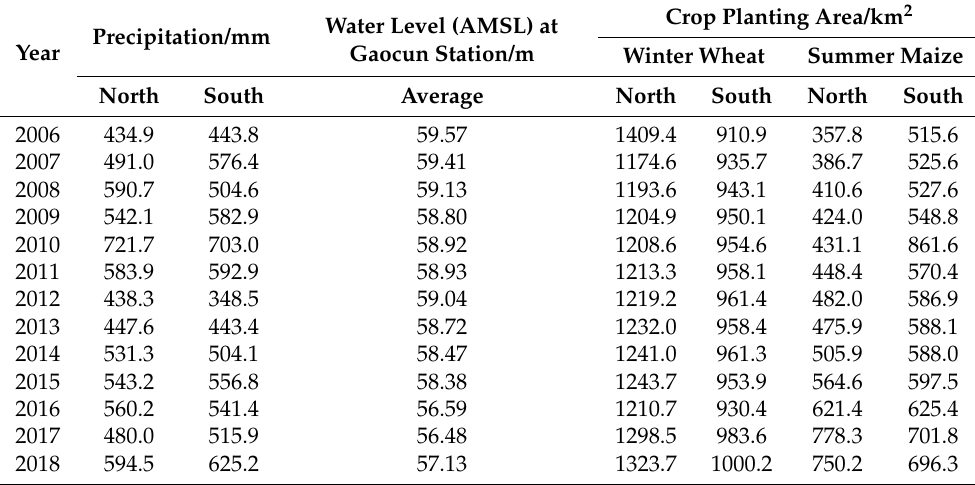
Figure 2. Distribution of observation wells of shallow groundwater in Puyang area. Table 1. Inter-annual variation of precipitation, the Yellow River stage, and crop planting area in Puyang from 2006 to